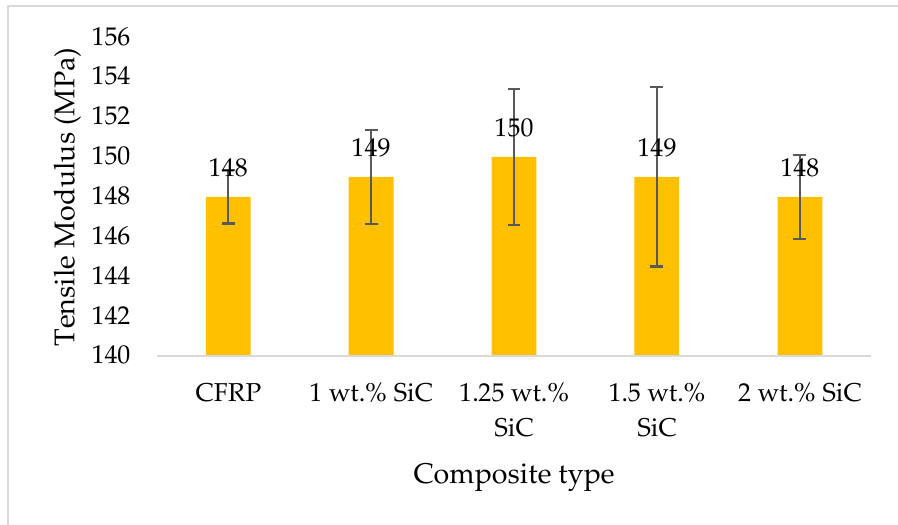
Figure 9. Tensile modulus of CFRP and hybrid SiC nano-composites.